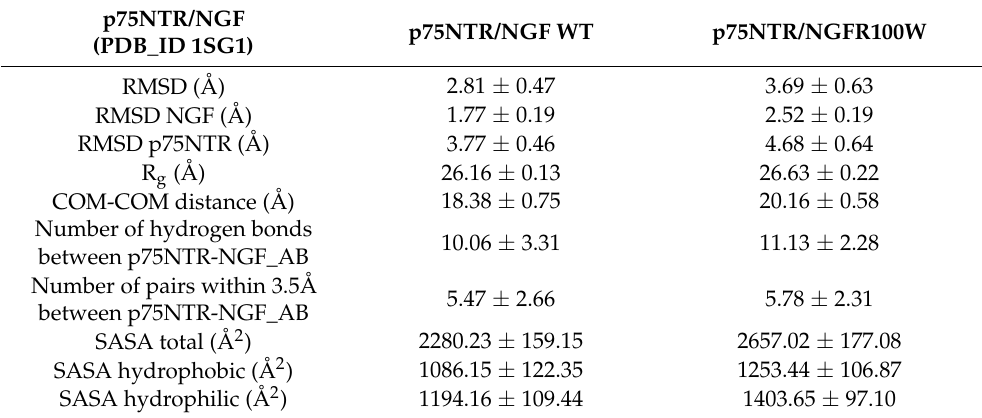
Table 1. Summary of the main structural parameters of the p75NTR/NGF complex after the emer- gence of the R100W mutation over the 100 ns simulation frame.